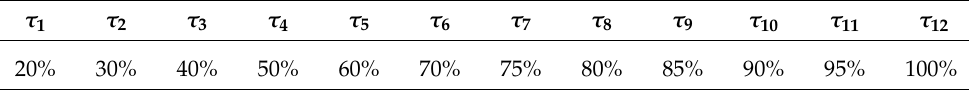
Table 4. Accelerator pedal end position τ i for the PON-maneuver.